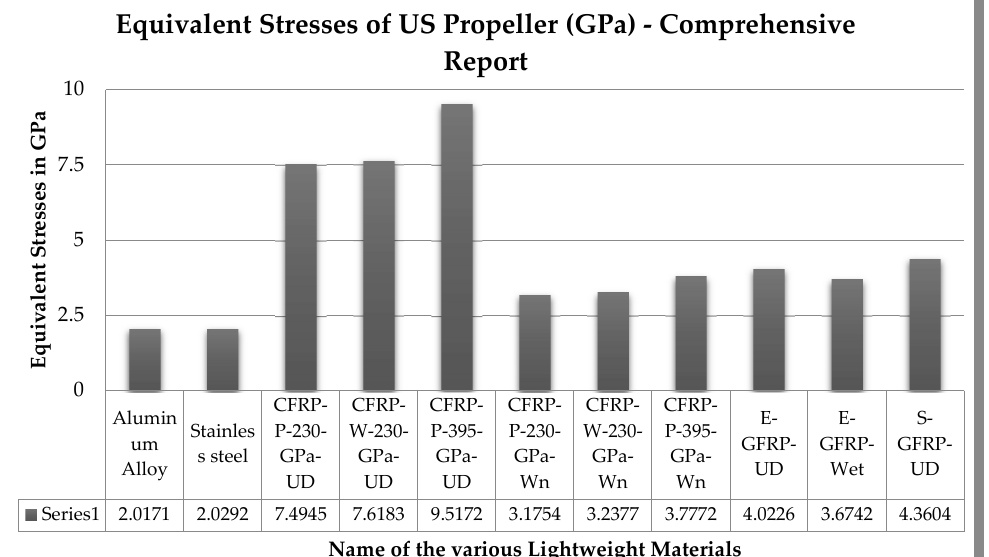
Figure 26. Comparative structural parameters 300 m with the speed of 20 m/s—Equivalent Stresses.